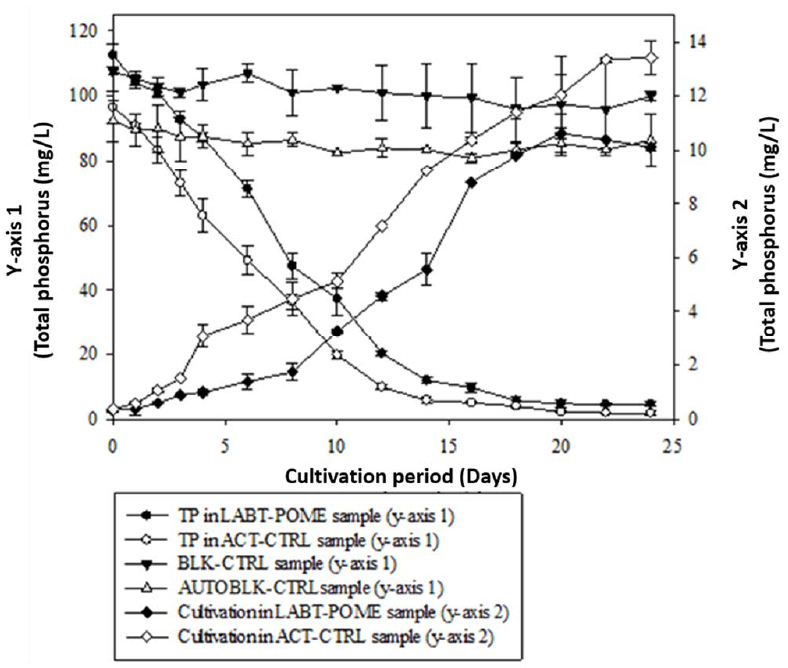
Figure 3. Phosphorus (TP) removal from LABT-POME by Chlorococcum oleofaciens .